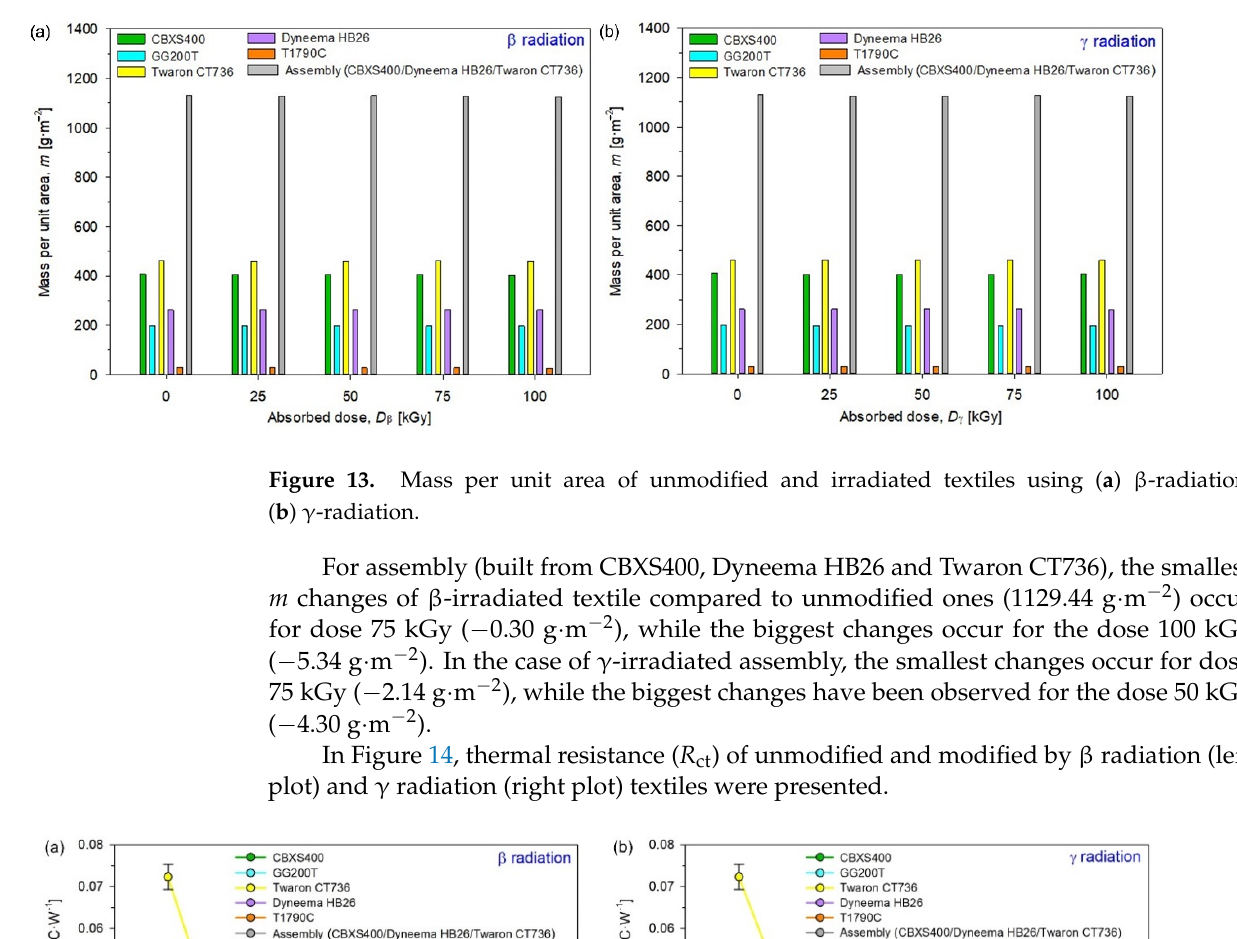
Figure 15. Maximum force of unmodified and β irradiated textiles.